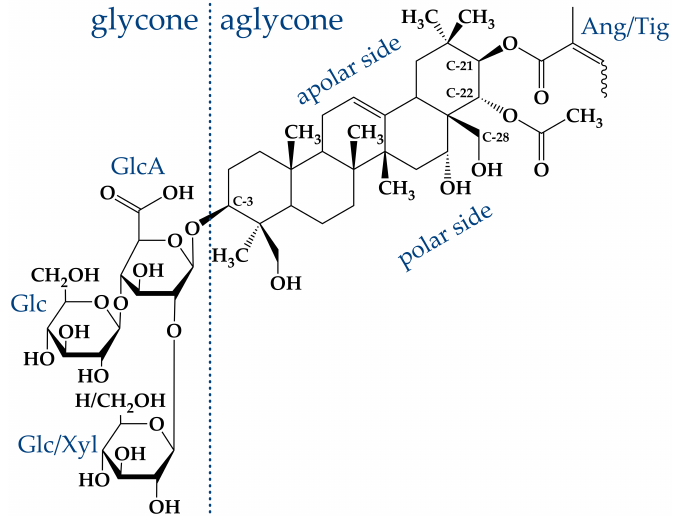
Figure 2. Molecular structure of β -aescin [29]. The amphiphilic structure of β -aescin consists of a hydrophobic, aglyconic part and a hydrophilic, glyconic part. The glyconic part contains glucuronic acid (GlcA), and glucose (Glc) (or xylose (Xyl)). However, in addition to the classical surfactant-like polarity, also within the aglyconic part polar groups are attached one-sided to the triterpene. This gives the aglyconic backbone a slightly polar and a slightly apolar side (Used abbreviations: Ang → angelic acid, Tig → tiglic